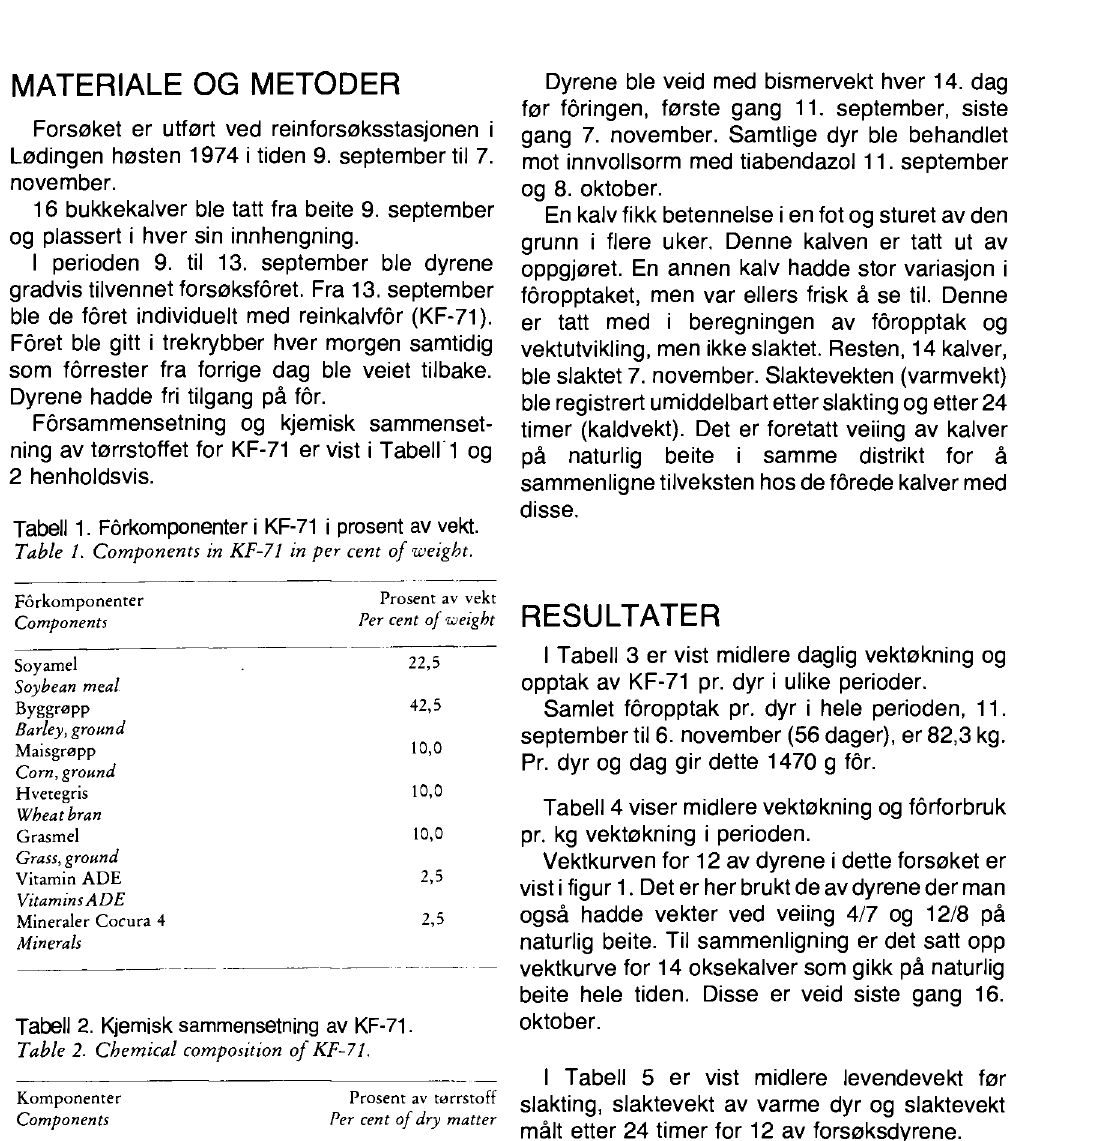
Table 2. Chemical composition of